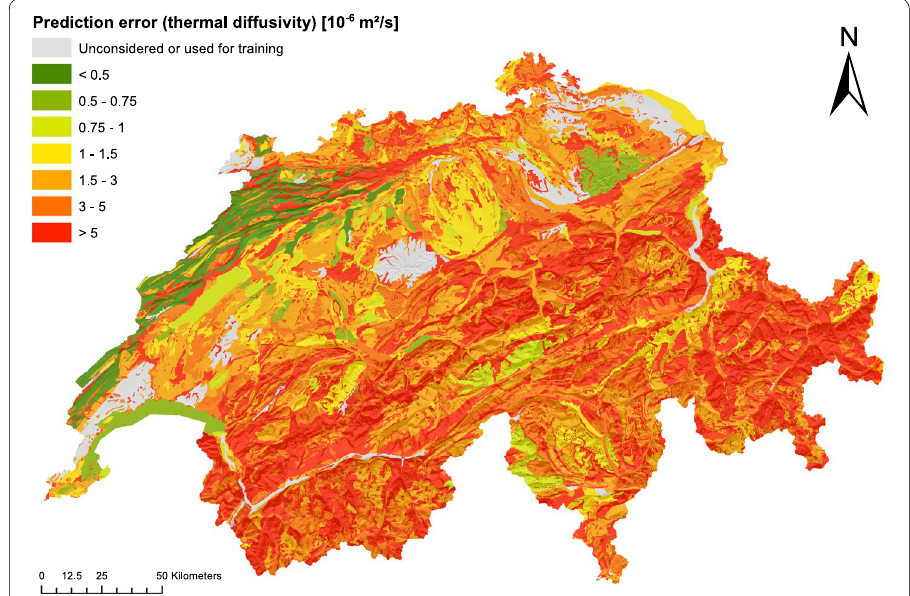
Fig. 17 Prediction error attached to the thermal diffusivity estimation (for each GK500 polygon). The error is computed as the average of the lower and upper ( PE s,down and PE s,up ) width of Prediction Intervals computed with Quantile Regression